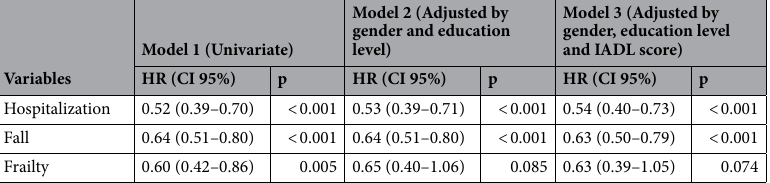
Table 3. Estimation of the effects of a moving into a senior housing on the risks of hospitalizations, falls, and frailty, Cox model. 3C study (n = 2095).